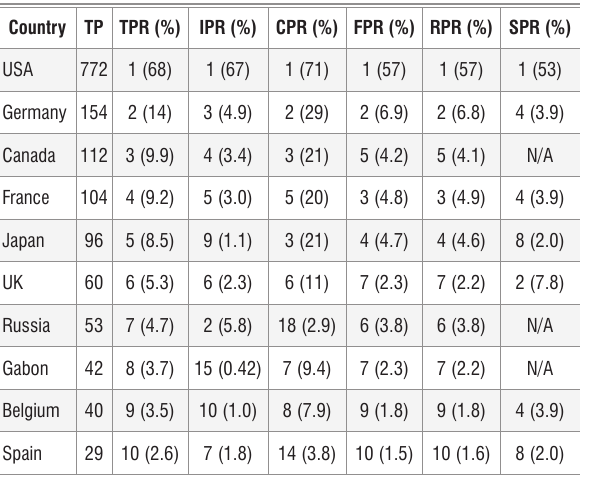
Ebola virus research: Country of